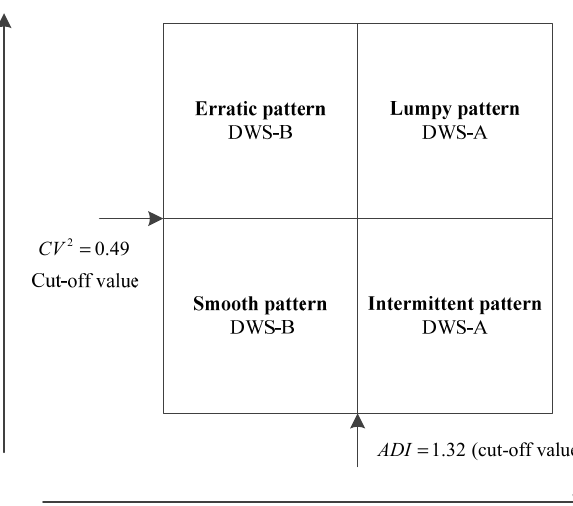
Figure 3. Optimal dynamic weighting strategies in the four demand patterns.